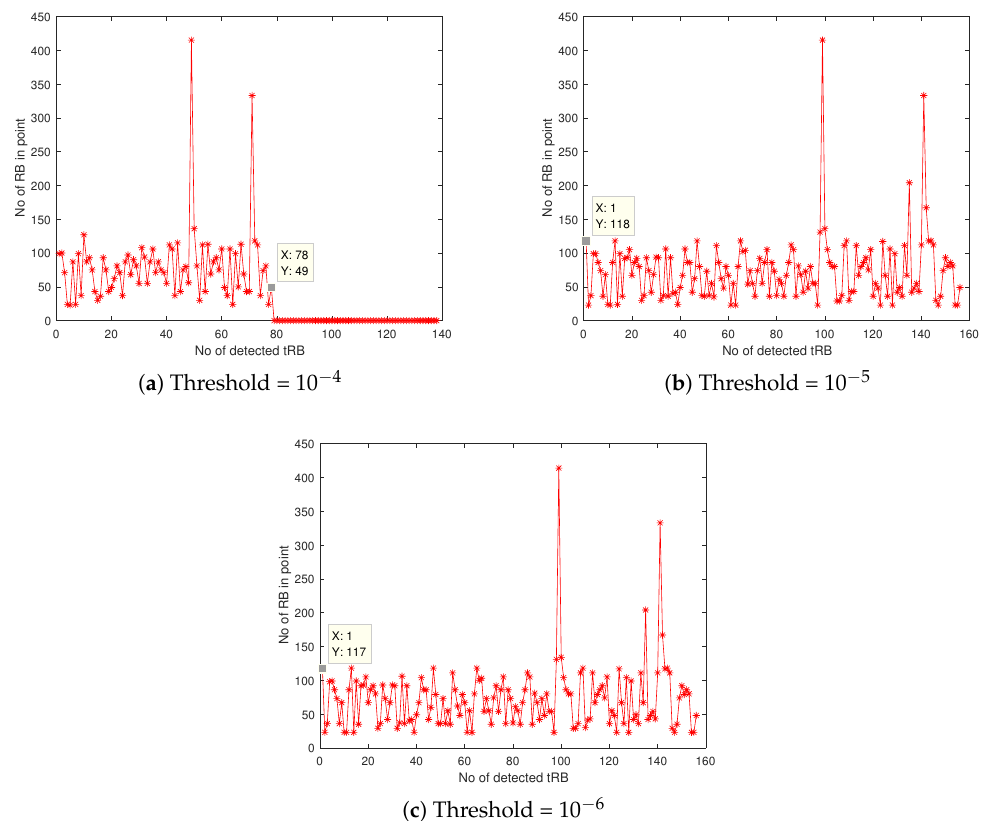
Figure 4. The number of idle times detected ( t RB ) with different threshold values: ( a ) 10 − 4 , ( b ) 10 − 5 and ( c ) 10 − 6